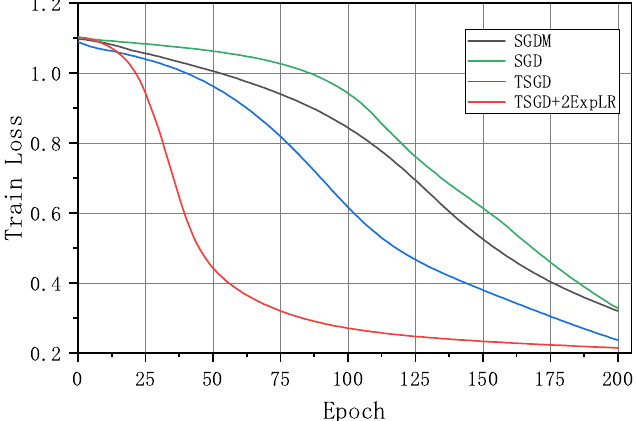
Figure 5. The loss of IRIS-BP-neural-network on the training set.